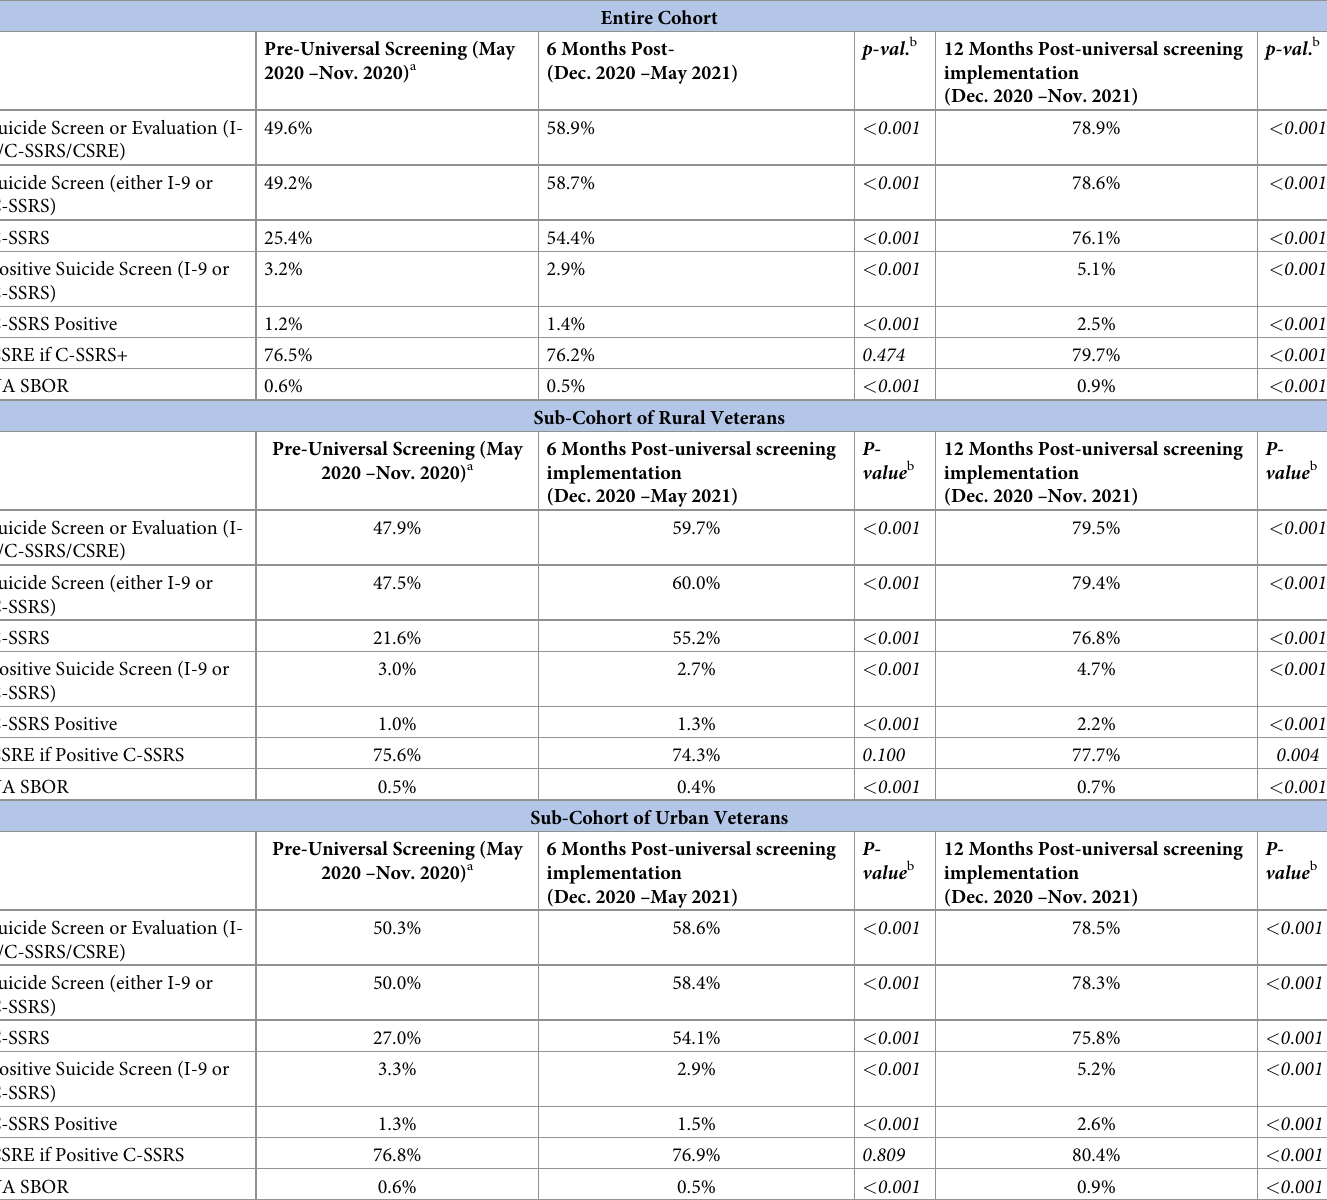
Table 2. Unadjusted percentage of Veterans in the study cohort with at least 1 VA visit for indicated reasons, pre- and post-universal screening implementation. Entire